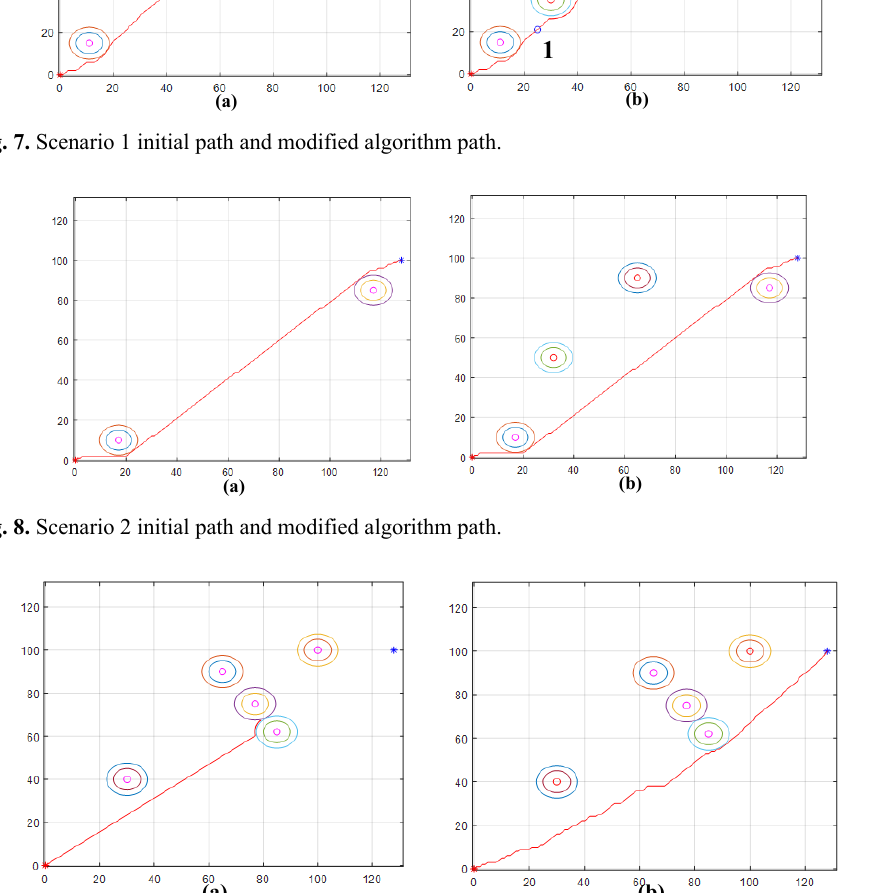
Fig. 9. Traditional artificial potential field algorithm and modified algorithm in scenario